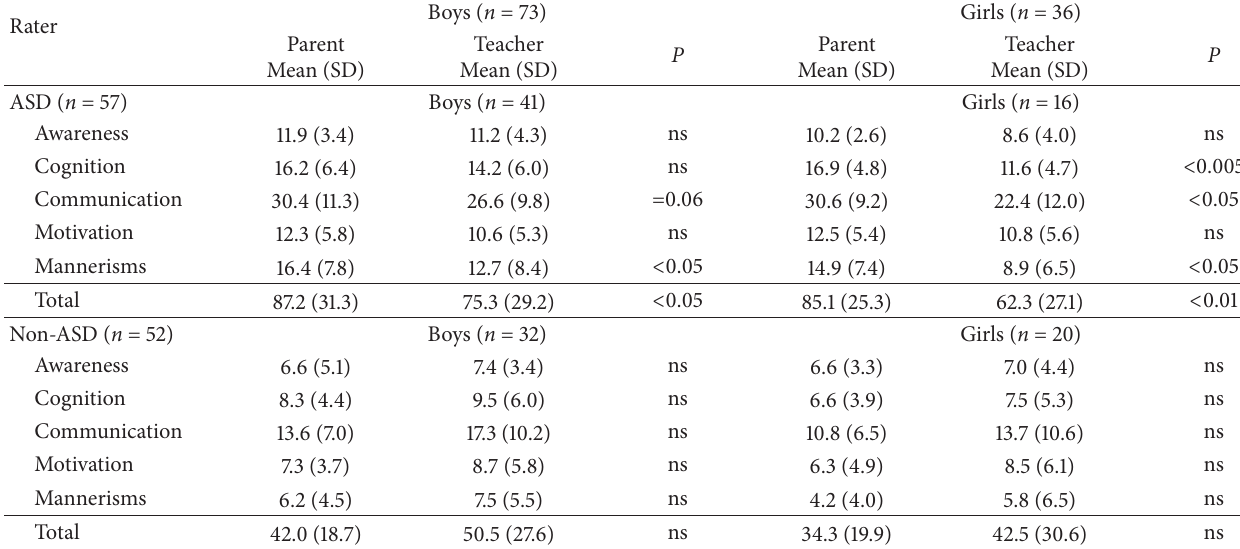
Table 4: Mean raw SRS scores of parent and teacher ratings of children with ASD and without ASD ( 𝑁 = 109